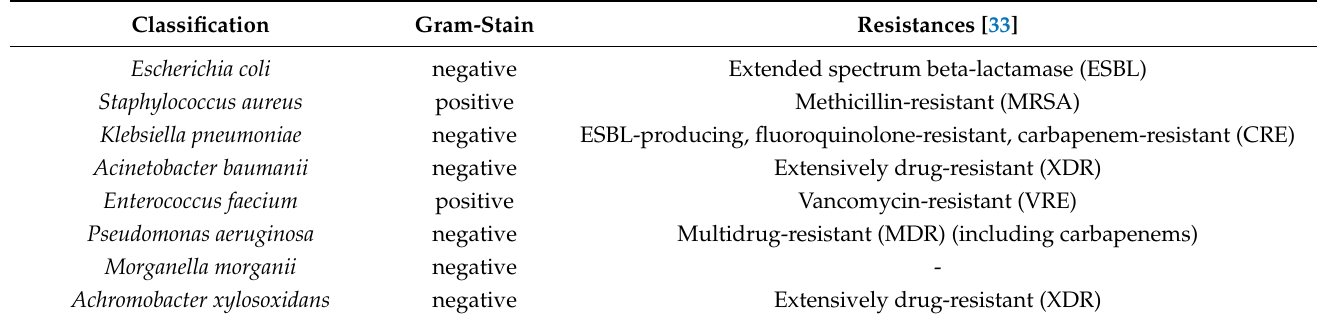
Table 1. Classification of bacterial strains by Gram-stain and antibiotic